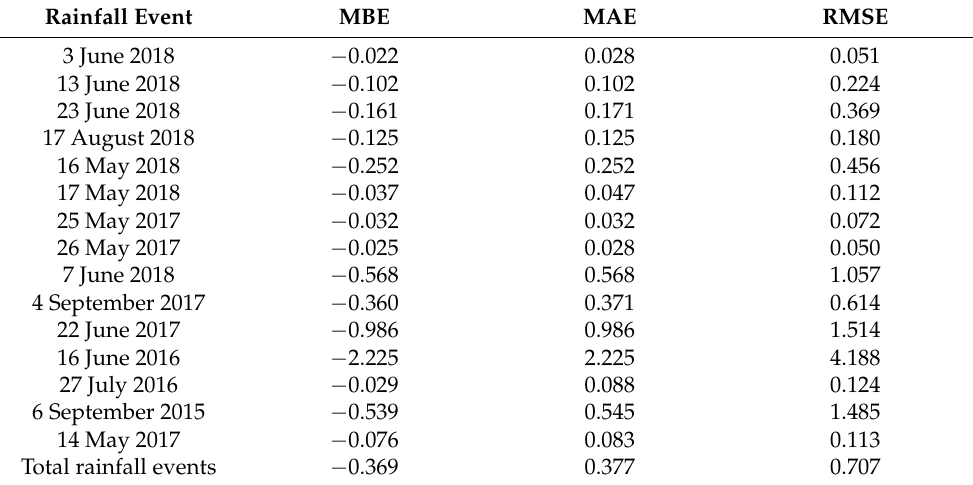
Table 5. Validation metrics computed for rainfall events. Rainfall